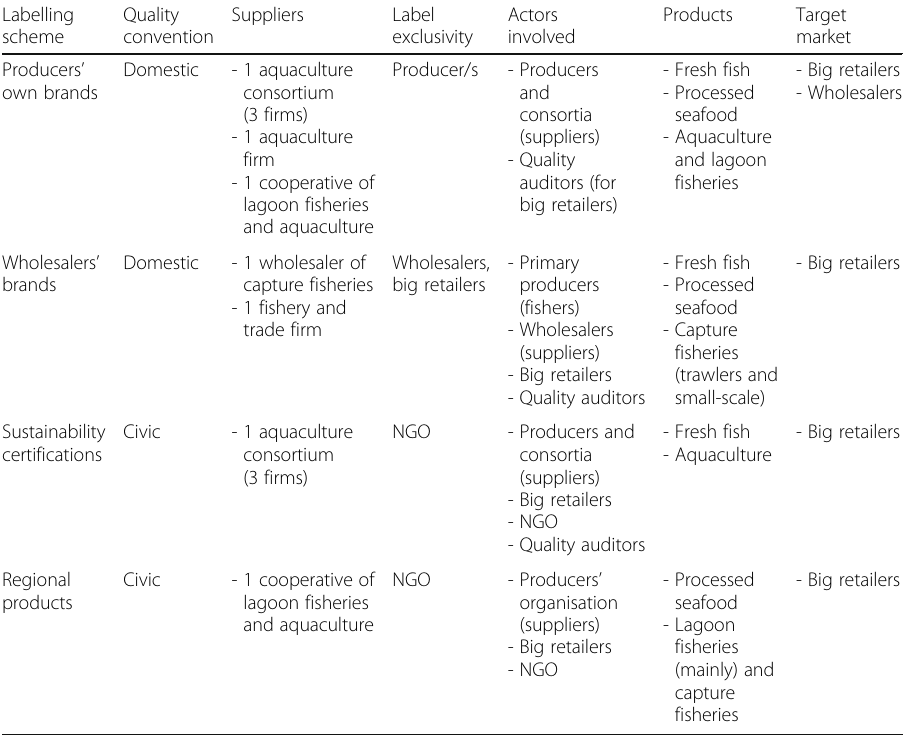
Table 1 Key features related to the labels adopted and the related quality conventions Labelling